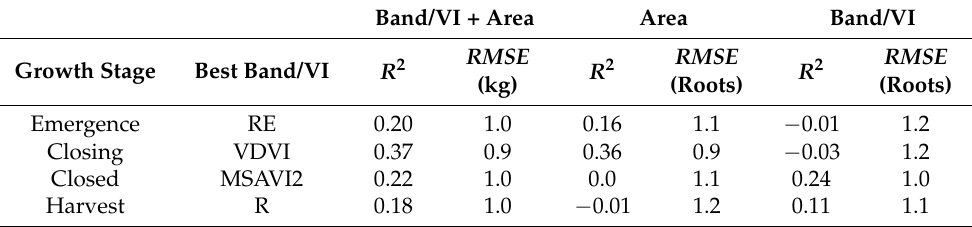
Table 5. Table beet root mass growth stage and band/VI assessment report with leave-one-out with canopy area MLR model and the linear regression scores of the individual features in New